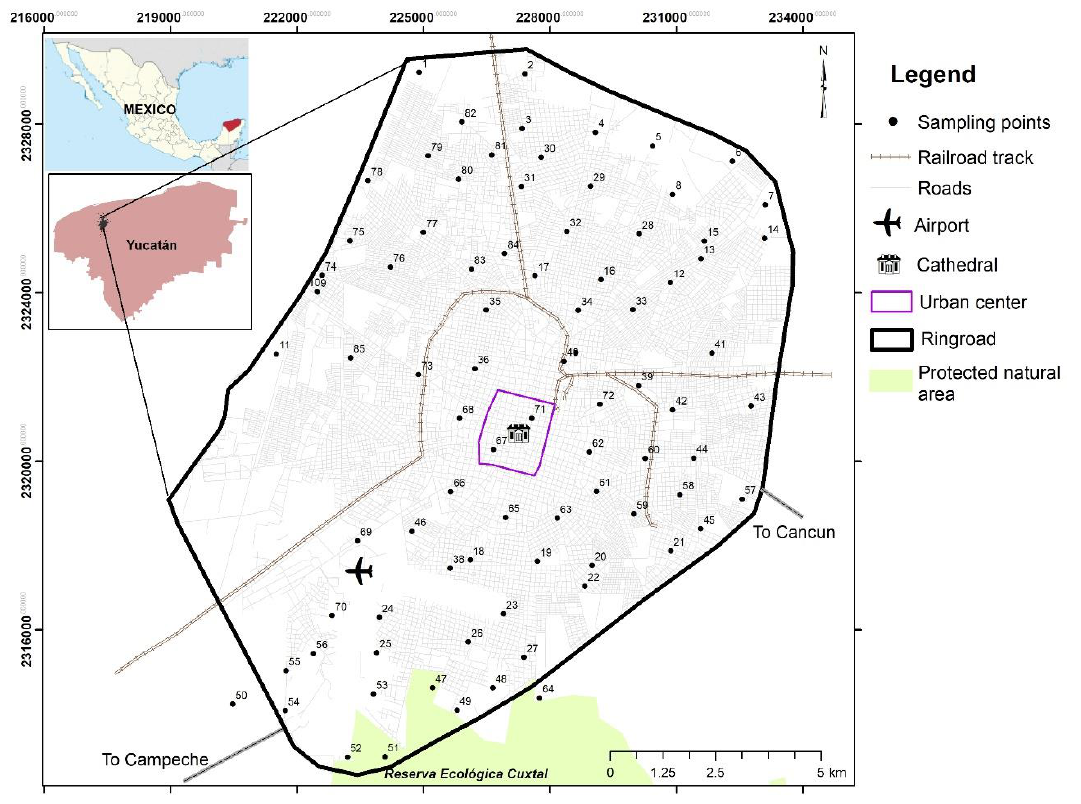
Figure 1. Geographical location of the road dust sampling sites.